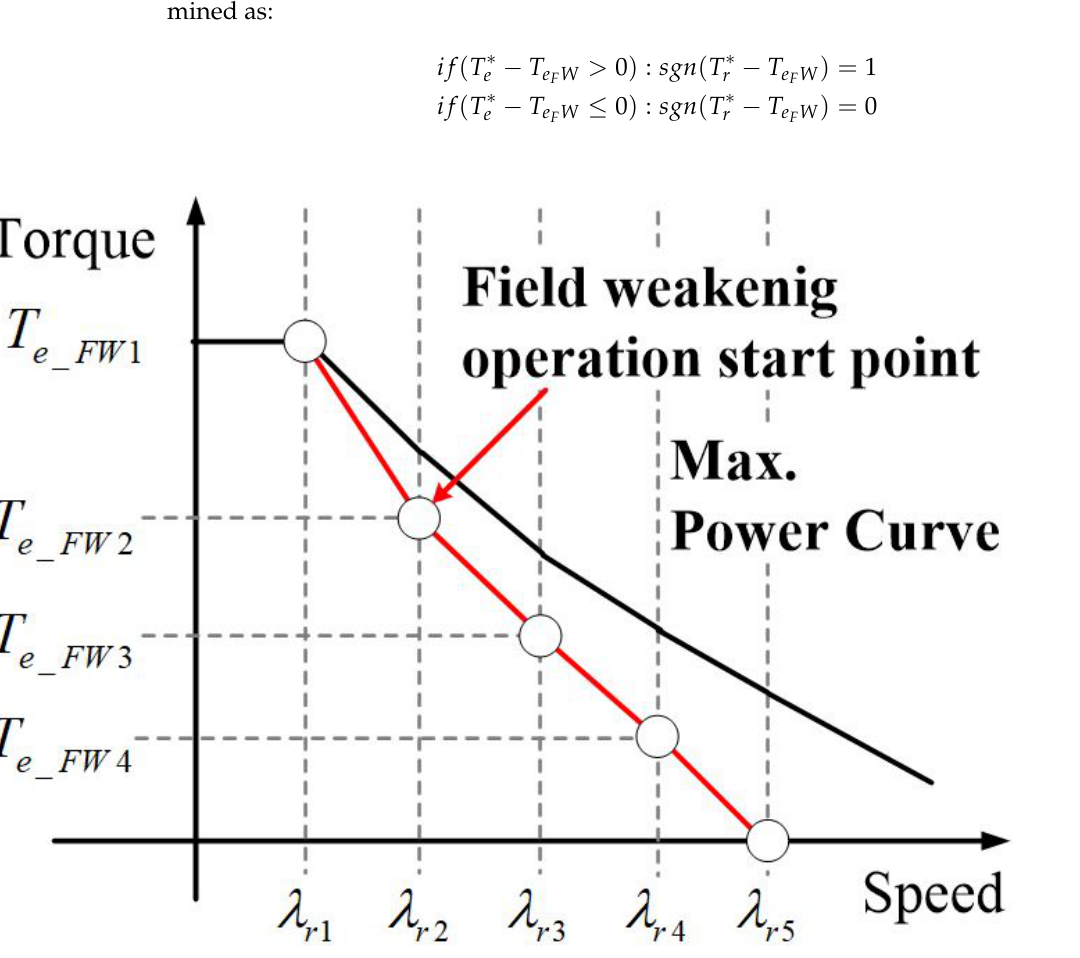
Figure 4. Field weakening operation start points of each